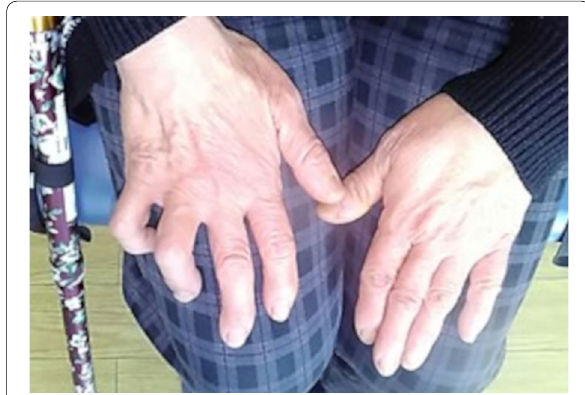
Fig. 1 The patient had paralysis of the right fourth and fifth fingers, known as “claw